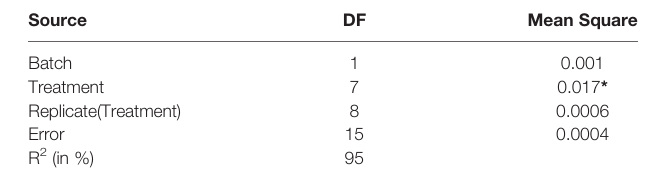
TABLE 5 | ANOVA for effect of batch, treatment and replicate (treatment).